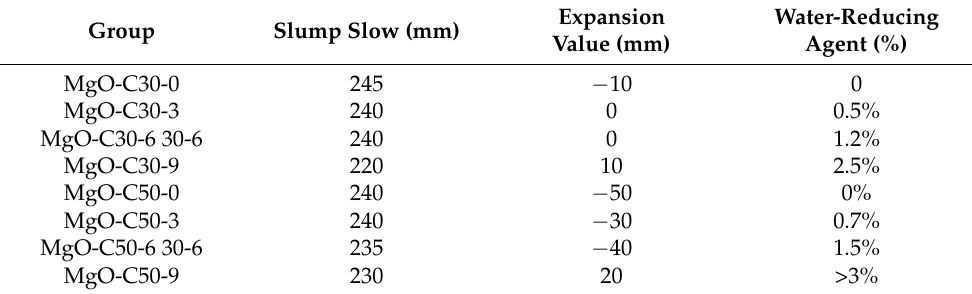
Table 4. The workability and water-reducing agent dosage of C30 and C50 concrete. Group Slump Slow